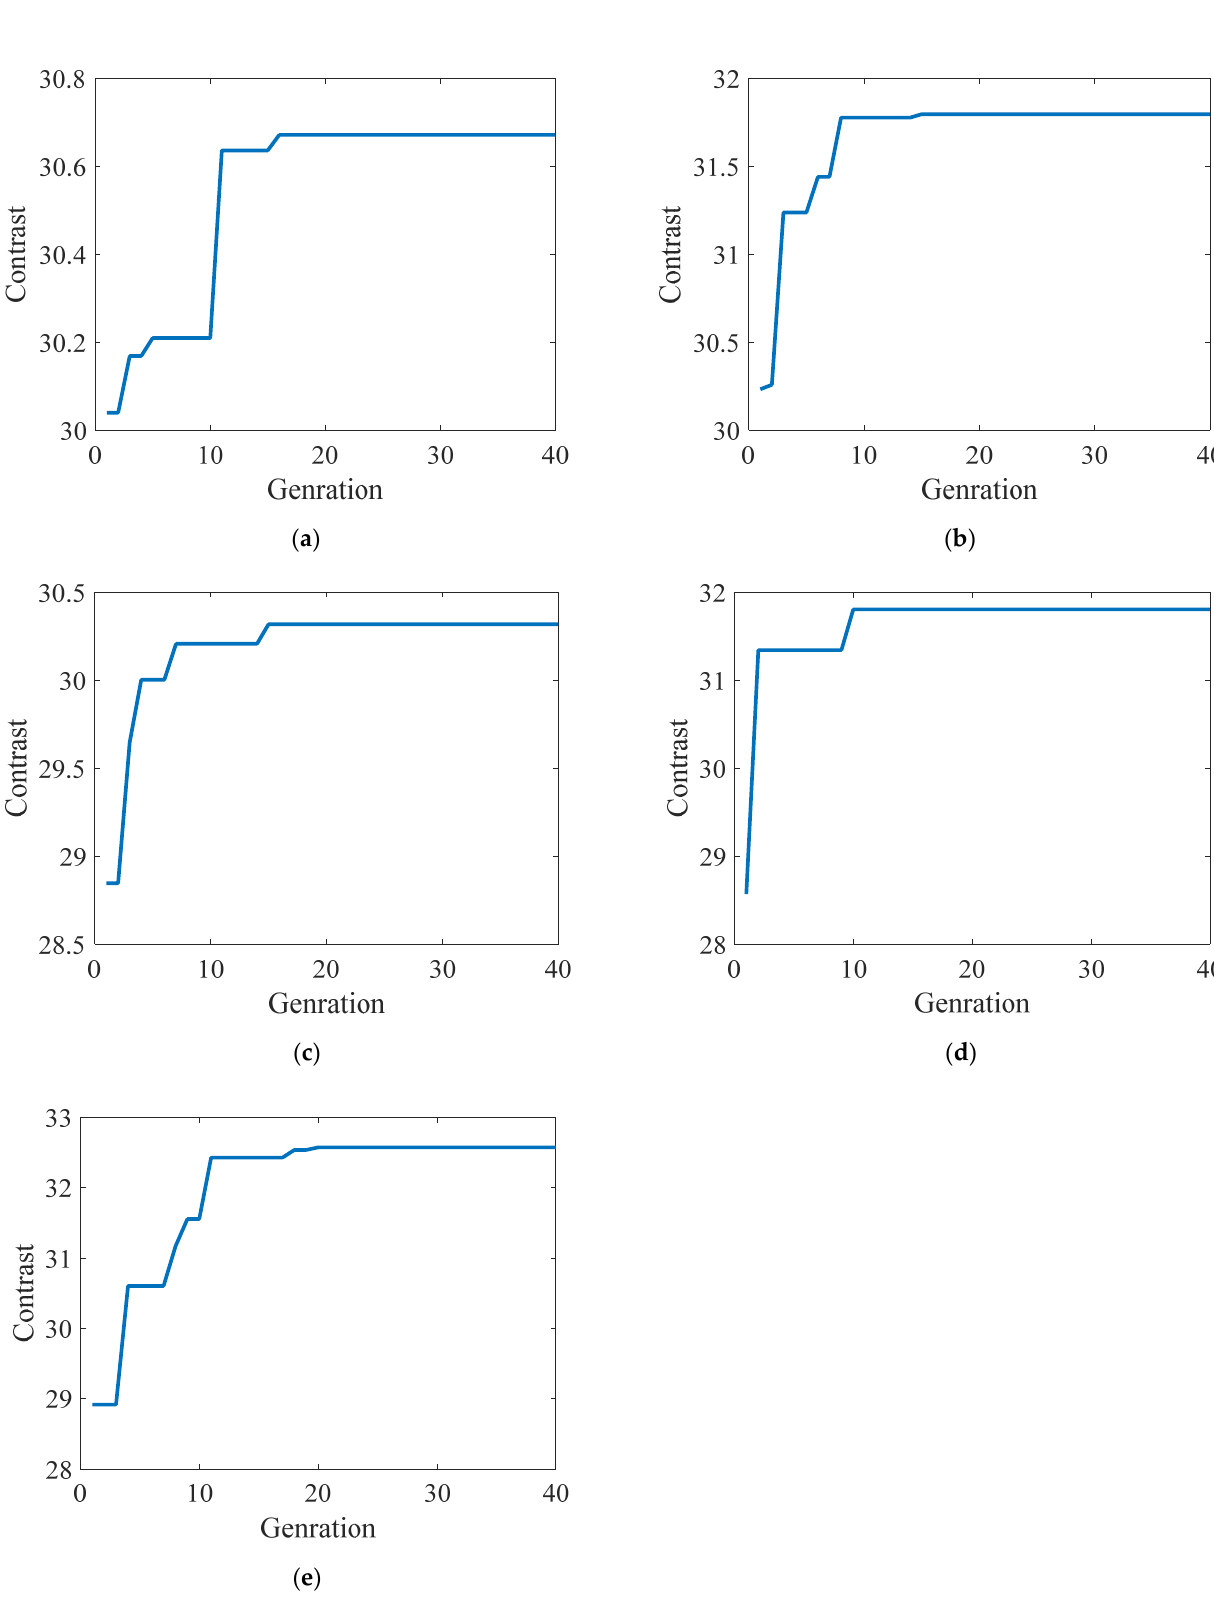
Figure 6. Solving processes of the optimization problem. ( a ) T1, ( b ) T2, ( c ) T3, ( d ) T4, and ( e ) T5.